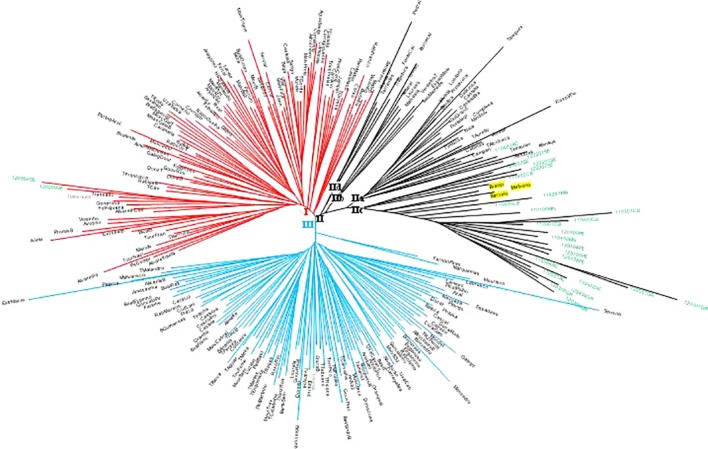
Neighbor-joining radiation tree showing genetic distance among Portuguese Vitis vinifera wild vines and varieties genotypes, based on 231 single nucleotide polymorphism (SNP) loci. Cluster I, solid lines in red color; cluster II, solid lines in black color; cluster III, solid lines in blue color; wild vine codes in green font; variety names in black font; cultivated grapevines with the wild group are highlighted in a yellow background.